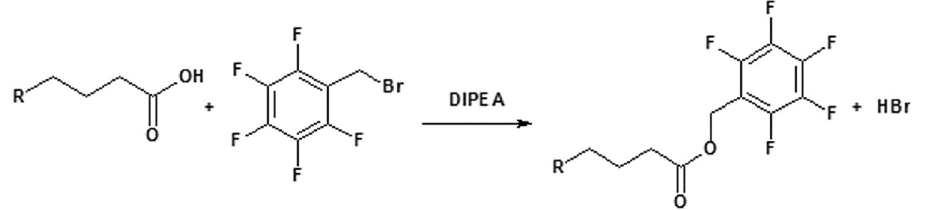
Figure 1. Reactions for the conversion of fatty acids into their pentafluorobenzyl esters using pentafluorobenzyl bromide